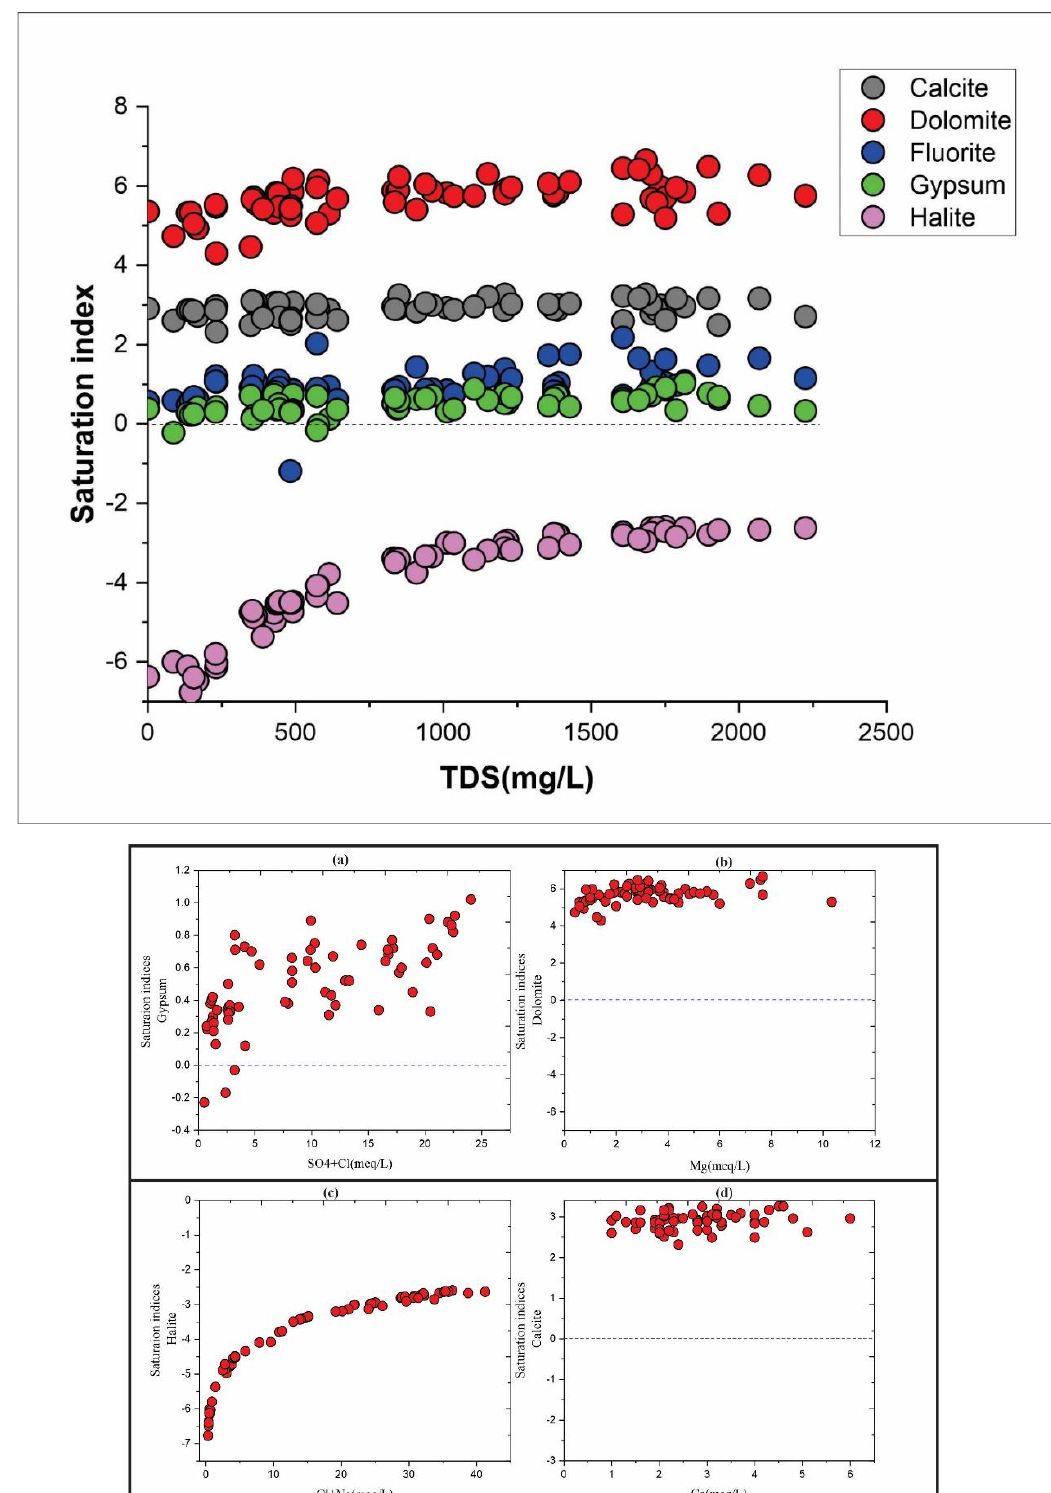
Figure 10. ( 1 ) Mineral saturation indices in groundwater samples with TDS. ( 2 ) Saturation index scatter plot of calcite, dolomite, halite and gypsum ( a – d ).